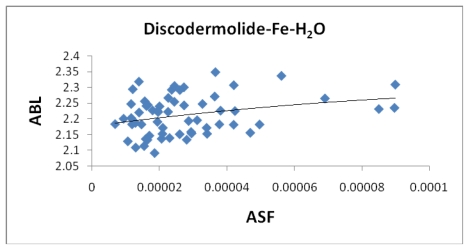
The average bond length (Å) plotted against the aqueous stability factor (Jm/D) for the Fe-Dis-H2O complex. The best fit line was determined to be the polynomial y = −5*106x2 + 1408x + 2.1771 (R2 = 0.0867).